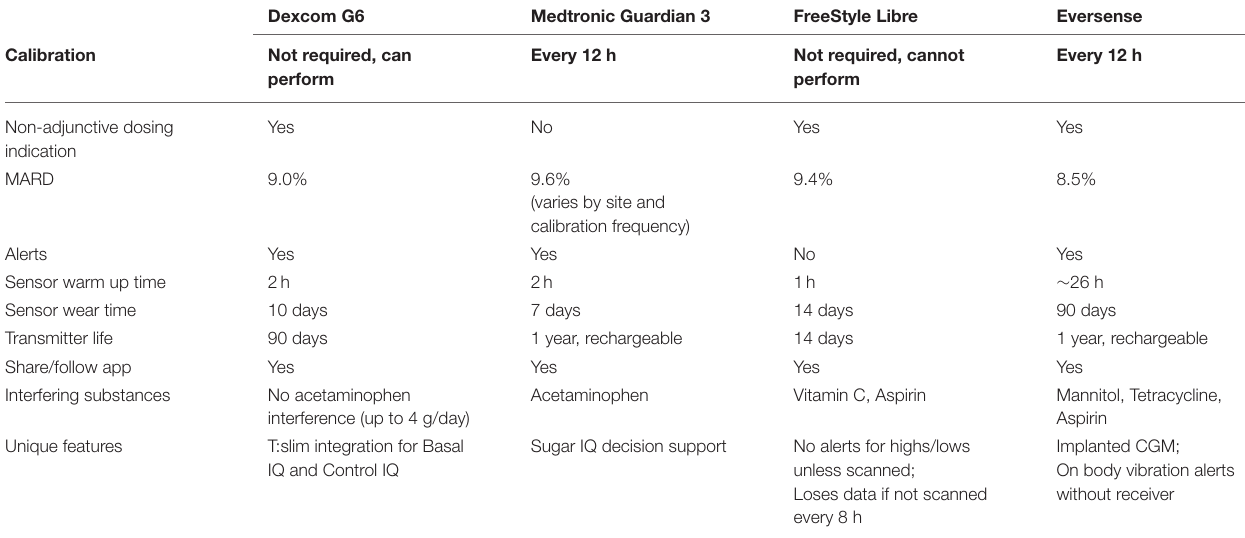
TABLE 5 | Comparison of currently available CGM systems.